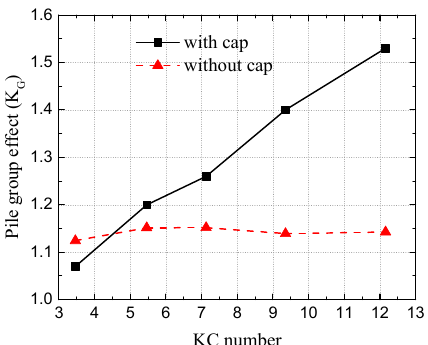
Figure 8. Variations of the pile group effect versus various KC numbers with the side-by-side arrangement of the pile group. Challenges 2017 , 8 , 30